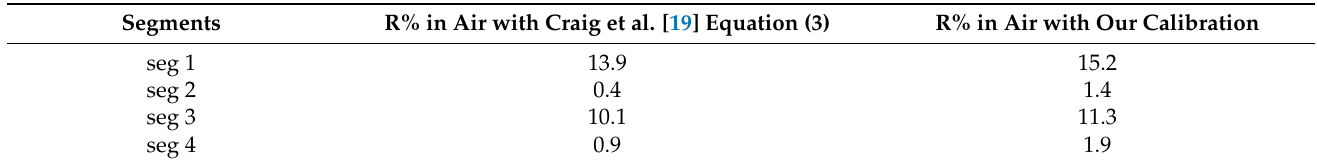
Table 2. Values of reflectivity (R%) in air obtained after correction by the mean of the Euclidean distance